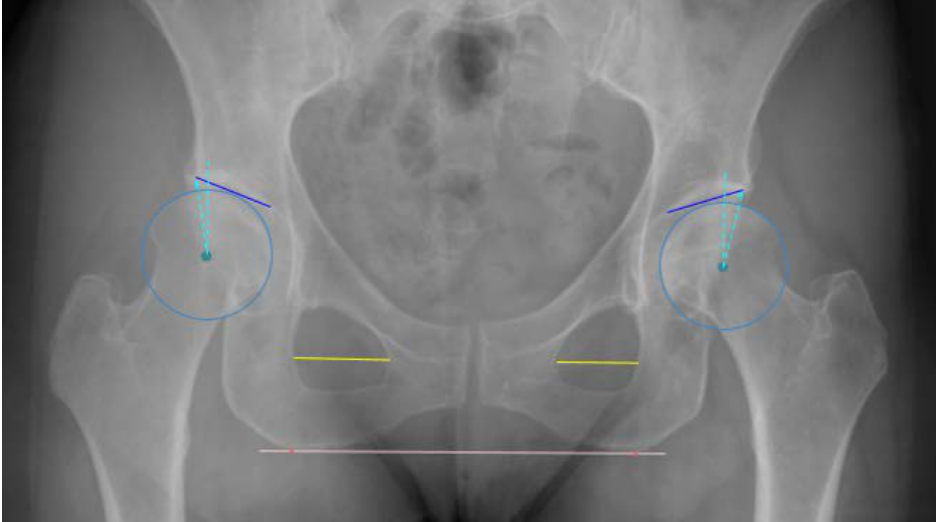
Figure 2. Pelvic radiograph depicting the horizontal reference line (pink line) through the most inferior points on the ischial tuberosities (red dots) and blue circles encompassing both femoral heads. The lateral center edge angel is the angle between two lines from the center of the femoral head (stabled blue lines), respectively, a vertical line perpendicular to the reference line and a line con- necting the center of the femoral head to the lateral sourcil of the acetabulum. The acetabular index angle is the angle between the horizontal reference line and a line (solid blue line) connecting the medial and lateral sourcils of the acetabulum. The foramen width is the length of a line across the widest part of the obturator foramen (Yellow lines) parallel to the horizontal reference line.